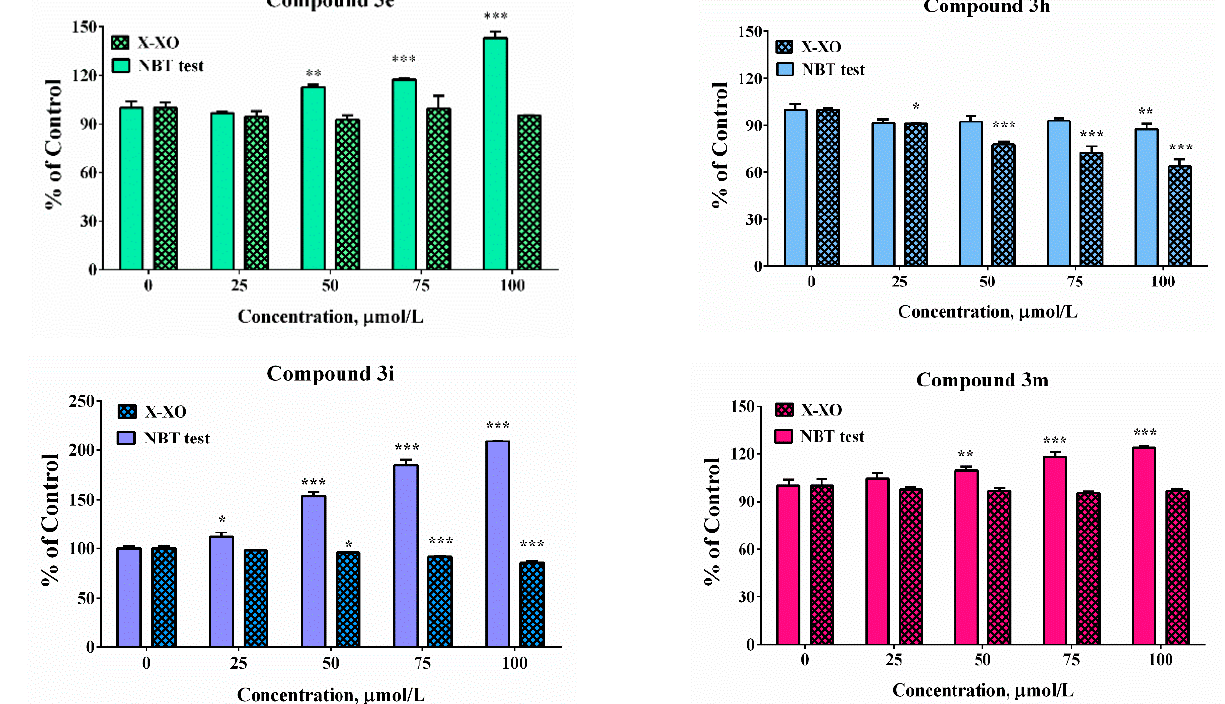
Figure 7. Scavenging abilities in model system with enzymatic (X-XO) and non-enzymatic generation of the superoxide anion radical. Results have been presented as percentage of the control sample. Data are presented as means from three independent experiments ± SD ( n = 3). * p < 0.05, ** p < 0.01, *** p < 0.001, vs. control sample for each assay (one-way ANOVA with Bonferroni post hoc test).